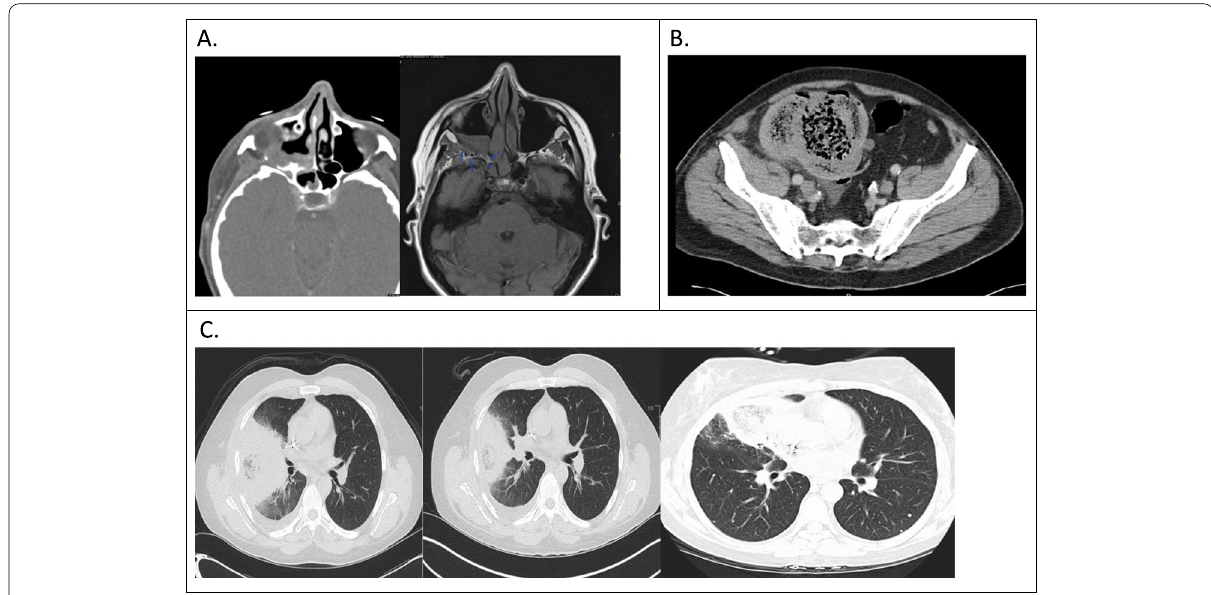
Fig. 1 Radiographic signs of mucormycosis. A Maxillary sinus mucormycosis. B Gastrointestinal mucormycosis of cecum. C Pulmonary mucormycosis: reversed halo sign on CT, an area of ground glass opacity surrounded by a ring of